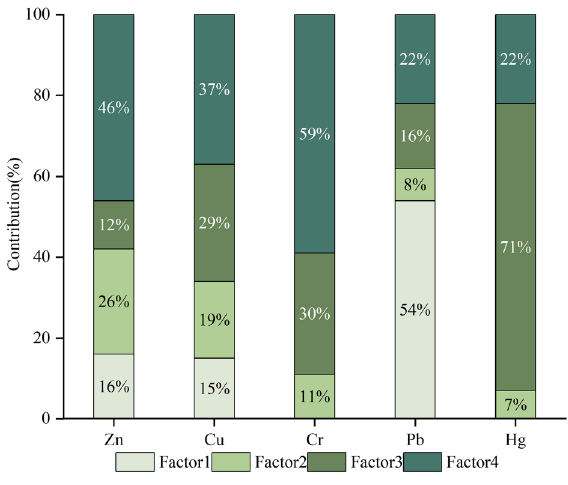
Figure 2. Unmix results. Software: Origin2021. URL: https:// www. origi nlab.